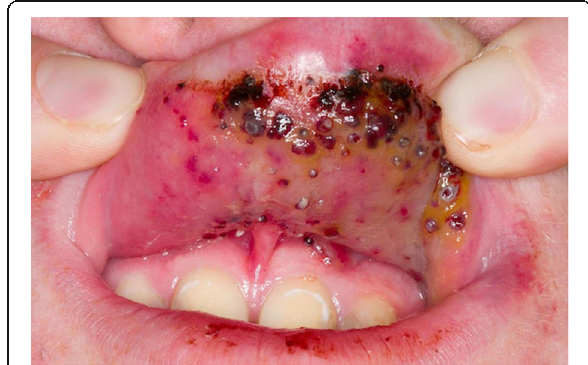
Fig. 8 Characteristic appearance of infected or inflamed lymphatic vesicles in a teenage child with a lymphatic malformation of the buccal mucosa